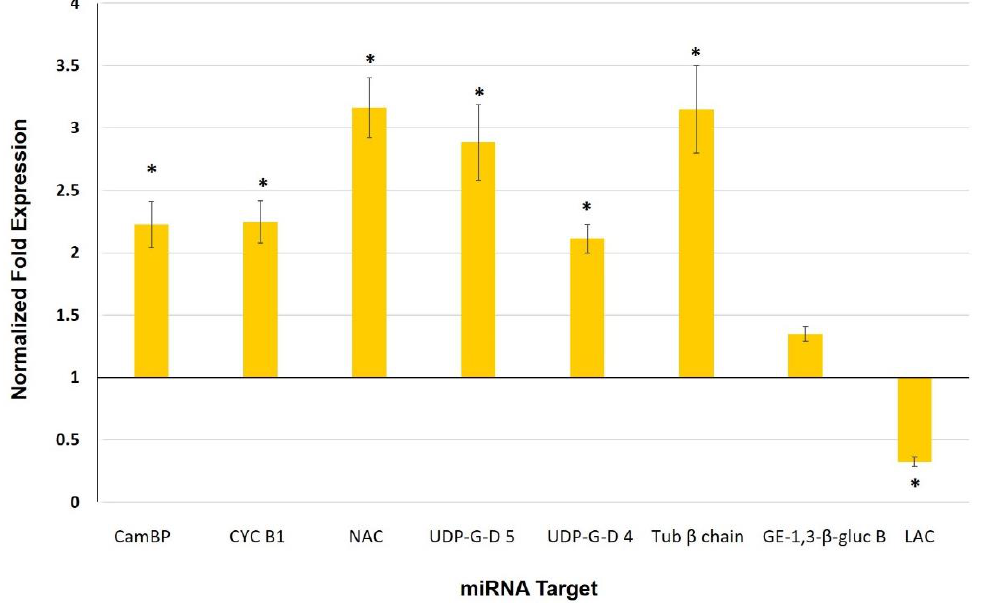
Figure 6. Normalized fold expression levels of miRNA target genes in leaves of mycorrhizal tomato plants. Expression was determined by qRT-PCR (2 − ∆∆ Ct ). Values represent the average ± SE of the normalized relative expression (MYC/CTR) from three independent biological experiments (n = 3 per experiment). Ubiquitin was used as a reference gene for data normalization. (*) represent significantly different means between MYC/CTR according to the statistical analysis (Student’s t -test, p ≤ 0.05). Bars, ± SE. (CamBP: Calmodulin binding protein; CYC B1: Cyclin B1; NAC: NAC domain protein; UDP-G-D5: UDP-glucoronic acid descarboxylase 5; UDP-G-D4: UDP-glucoronic acid descarboxylase 4; Tub β chain: Tubulin beta chain; GE-1,3- β -gluc B: Glucan endo-1,3- β -glucosidase B; LAC: